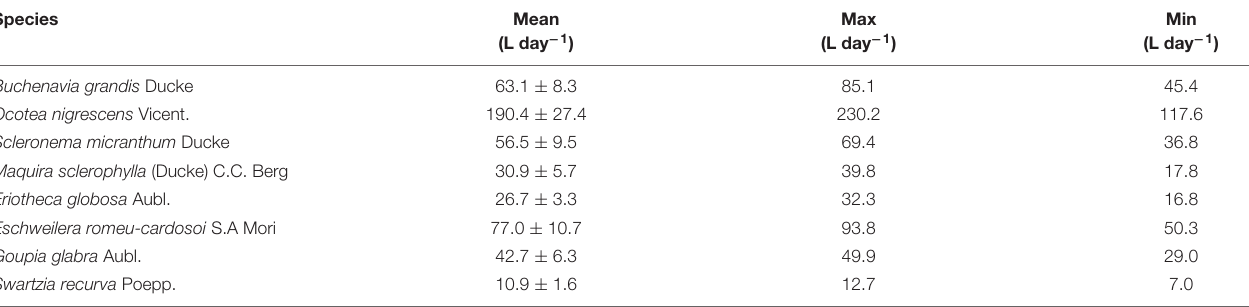
FIGURE 4 | Normalized daily transpiration based on scaled radial patterns of sap flow from eight dominant canopy trees during the dry period from September 16 to October 16, 2018 for days with mean VPD above 1 kPa. Tree diameter (DBH; cm), height (HT; m) and sapwood area (SA; cm 2 ) are indicated for each tree. The shaded area represents the 95% confidence interval. TABLE 2 | Mean, maximum, and minimum ( ± SD ) daily transpiration by species from September 16 to October 16, 2018 based on scaled radial patterns of sap flow.